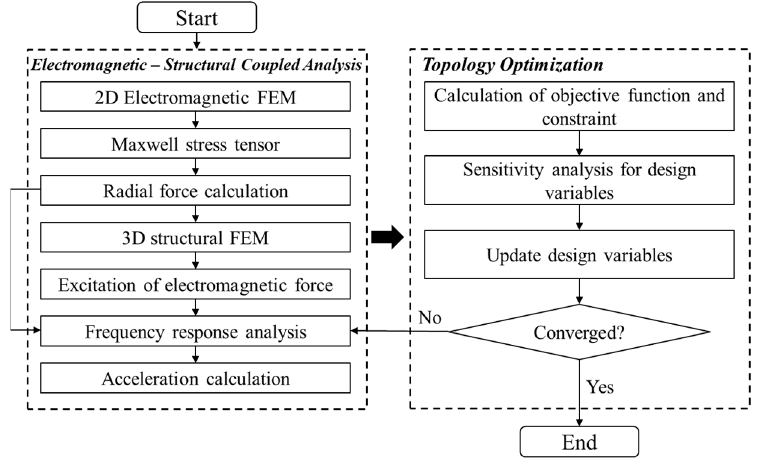
Figure 5. Procedure of topology optimization using electromagnetic-structural coupled analysis.